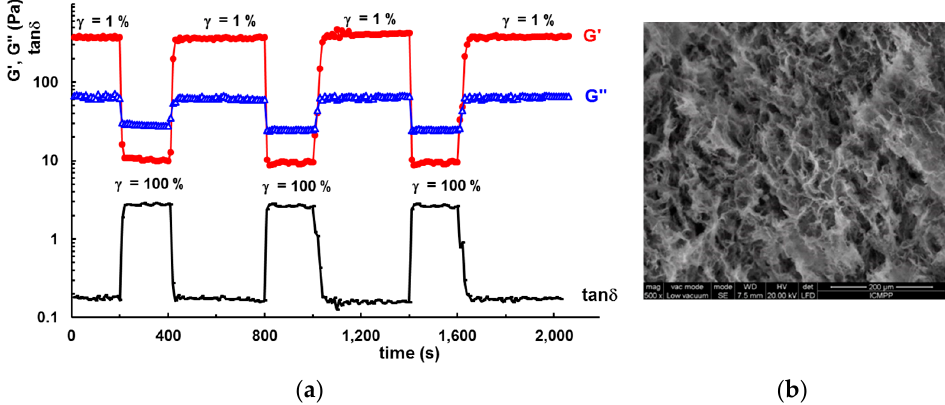
Figure 7. ( a ) The evolution of the viscoelastic parameters (G ′ , G ″ and tan δ ) for a hybrid hydrogel during three successive runs of low ( γ = 1%) and high ( γ = 100%) strain values, at 37 °C and pH = 7.4. ( b ) The SEM micrograph shows the morphology of composite hydrogel [24]. Reprinted with permission from Ref. [24]. Copyright 2022, MDPI.